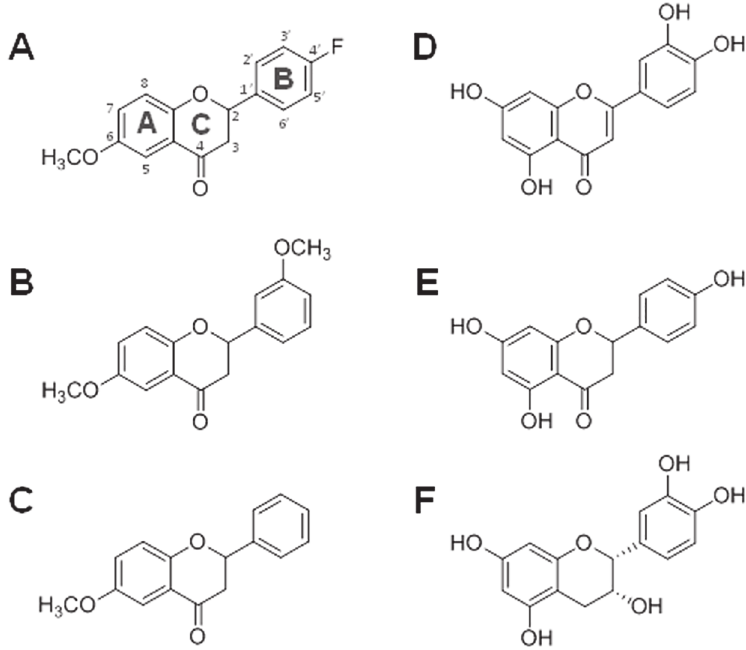
Fig 4. Structures of hTAS2R39 blockers (A-C) and agonists (D-F). 4 ’ -fluoro-6-methoxyflavanone ( A ), 6,3 ’ - dimethoxyflavanone ( B ), 6-methoxyflavanone ( C ), luteolin ( D ), naringenin ( E ), and epicatechin ( F ). Flavonoid- specific ring nomenclature (A/B/C-ring) and the atom numbers are illustrated in ( A